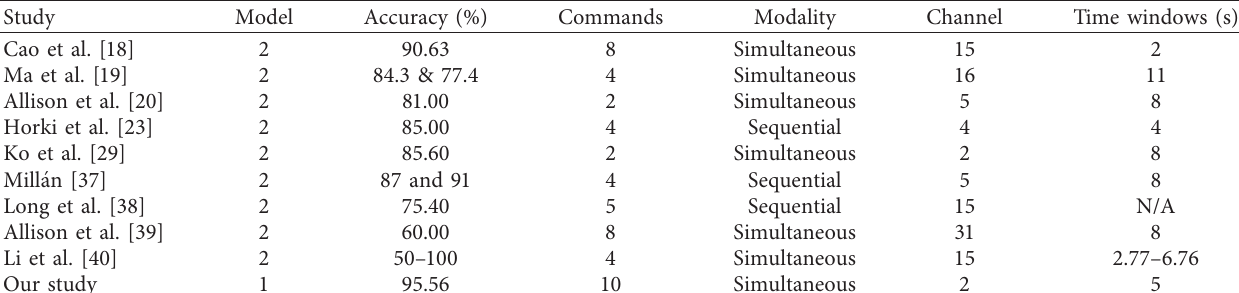
Figure 8: The performance for the MI single system (a, d), SSVEP single system (b, e), and hybrid MI and SSVEP system (c, Table 2: Comparison of different studies for hybrid MI +SSVEP-based BCI systems.